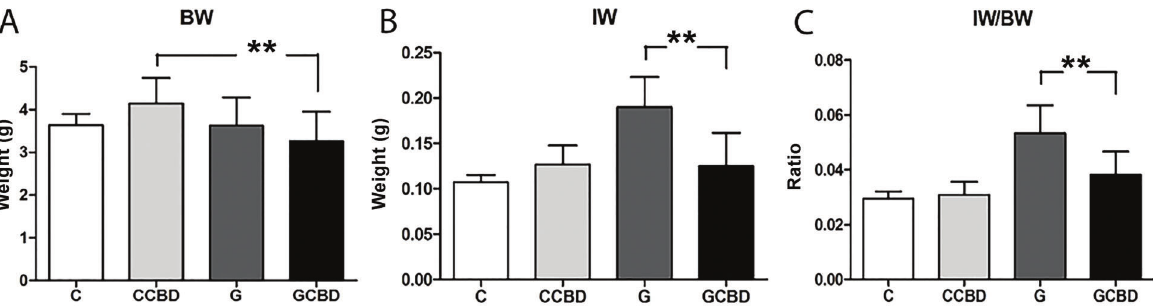
Figure 2. Morphological analysis. Data are reported as means ± SD. A , body weight (BW; g). B , intestinal weight (IW, g). C , Intestinal weight/body weight ratio (IW/BW). C: control; CCBD: control + cannabidiol; G: gastroschisis; GCBD: gastroschisis + cannabidiol. **P o 0.005